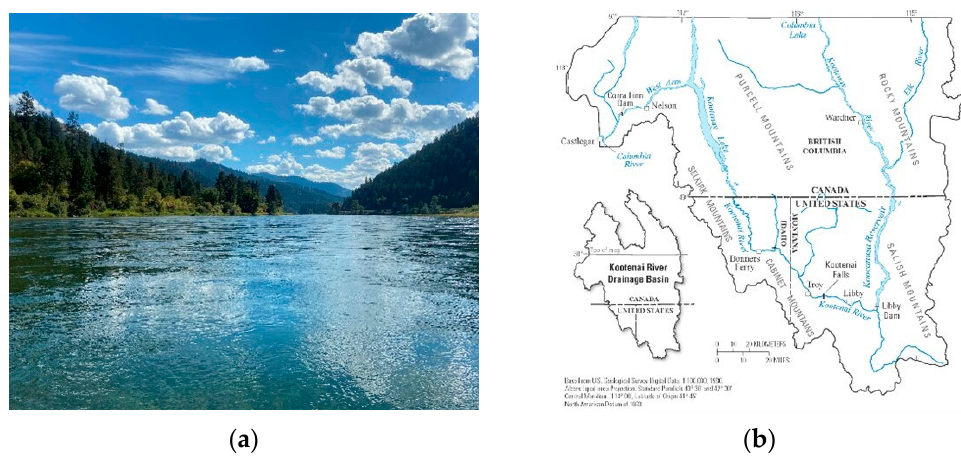
Figure 10. Information of the Kootenai river obtained from the United States Geological Survey. ( a ) Kootenai River; ( b ) map of Kootenai River. Table 5. Basic information of Kootenai River.